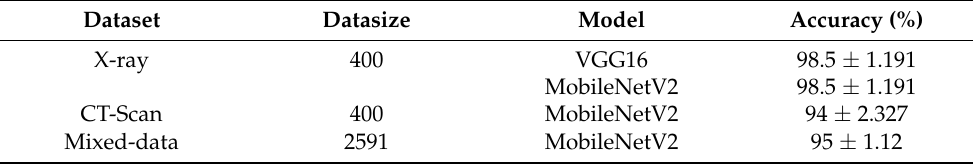
Table 4. Top-performing models in terms of accuracy and different datasets